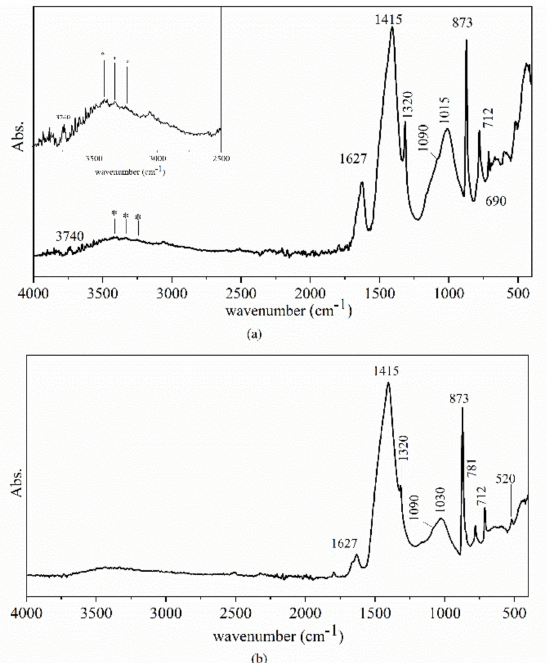
Figure 4. ATR-FTIR-spectra of samples MY33 ( a ) and MY45 ( b ). The infrared bands are reported and the pattern of the OH stretching vibrations highlighted with an asterisk (*) is better illustrated in the detail of figure ( a